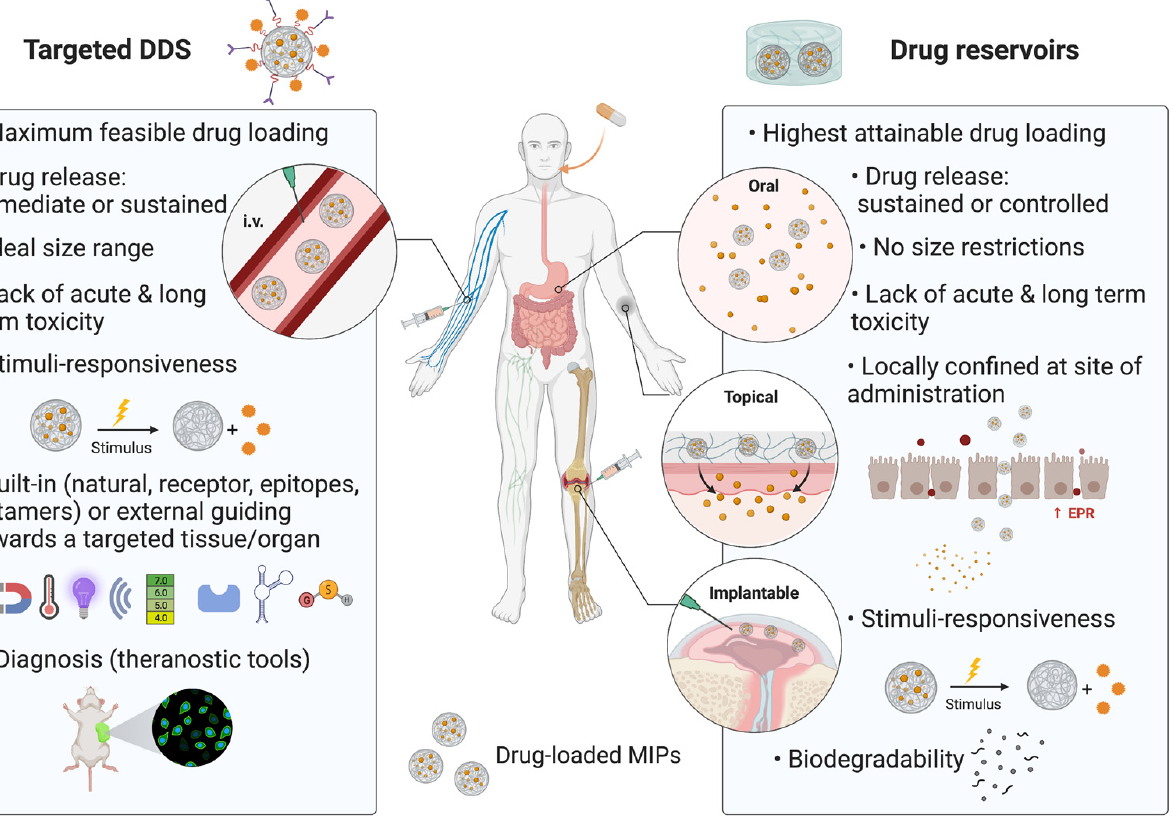
Figure 1. Comparison of the critical features of MIP-based drug delivery systems. The main differ- ences and similarities between targeted DDS and drug reservoirs are shown in Figure 1. Both classes ought to lack toxic effects and can be designed as stimuli-responsive.